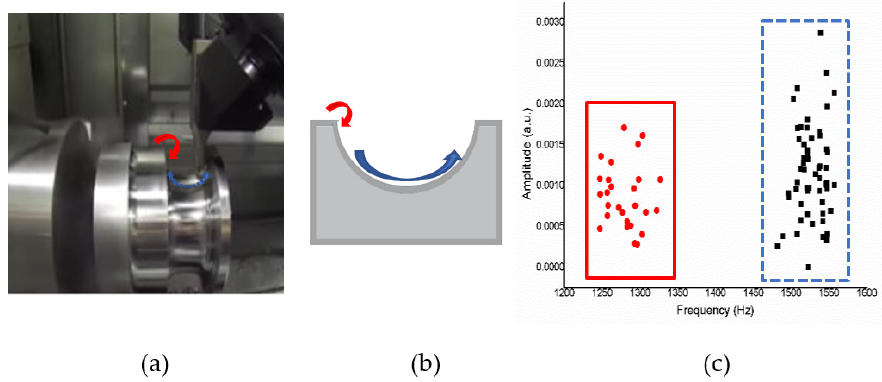
Figure 11. ( a ) Operation sketch, ( b ) trajectory of tool, ( c ) frequency of milling process for XZ axes.